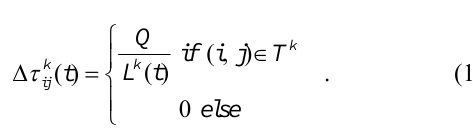
Figure 1. From the discrete probability law to the continuous one ant has completed its solution, a pheromone deposit process along the edges of the grid is made. Let L k be the length of the path after one complete tour for the ant number k. (i,j) denotes the edge connecting the i and j towns, the deposit for the k th ant on the ( i , j ) edge after one tour is given by